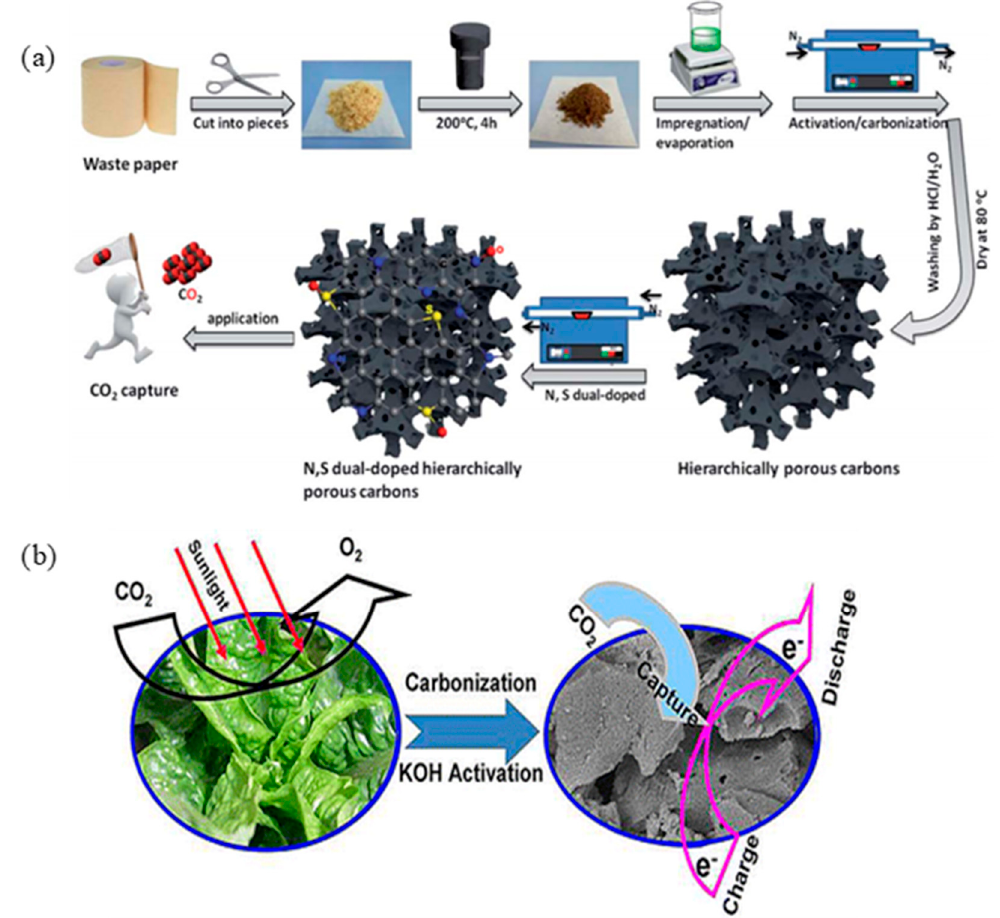
Figure 3. ACs (activated carbons) preparation from ( a ) waste paper and ( b ) biomass [73,74]. Reproduced with permissions from the references of [73,74]; Copyright © 2019, Royal Society of Chemistry and Copyright © 2012, American Chemical Society;